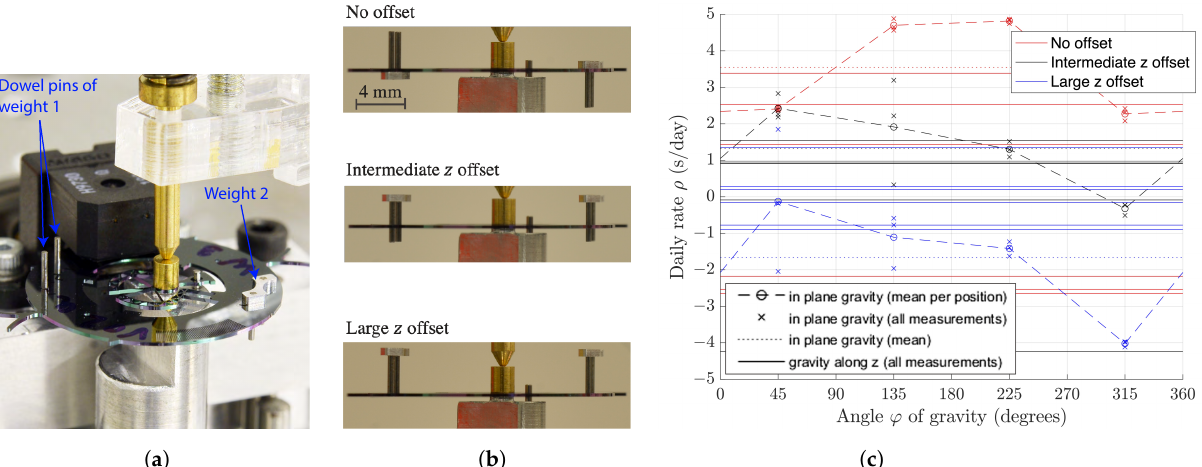
Figure 10. Experimental validation of the effect of offsetting the COM of a flexure pivot from its plane of motion using a co-RCC silicon prototype with external weights on slidable dowel pins: ( a ) prototype on test bench with symmetrical weights, ( b ) side view of the prototype with three different implementations of COM offset and ( c ) daily rate for varying orientations with respect to gravity for these three